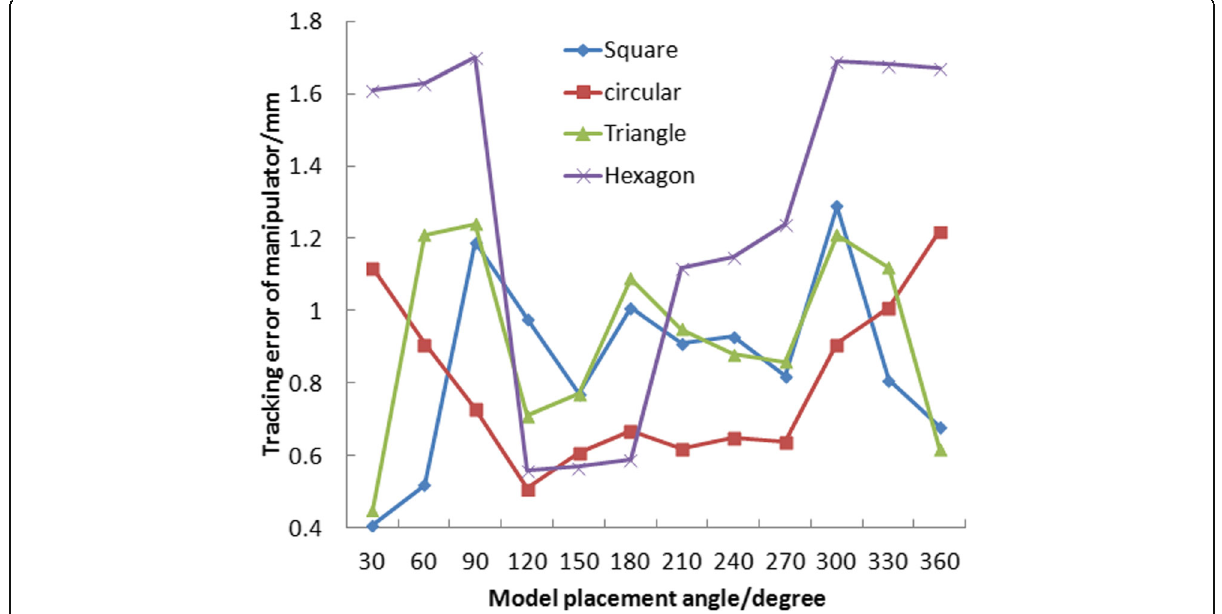
Fig. 7 Robot arm positioning error at different model placement